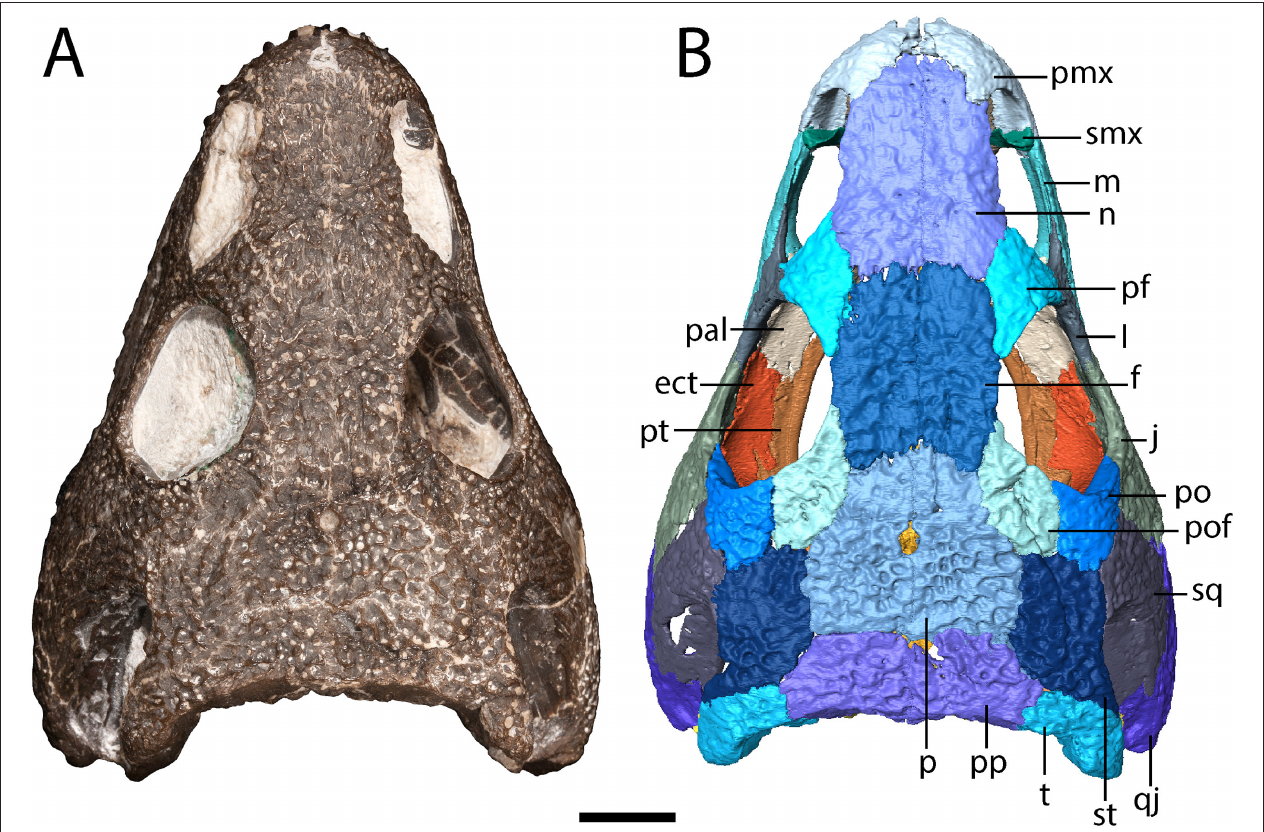
FIGURE 1 | OMNH 79318, cf. Acheloma , entire specimen in dorsal profile. (A) photograph; (B) digitally segmented rendering of the skull roof and palate. Scale bar equal to